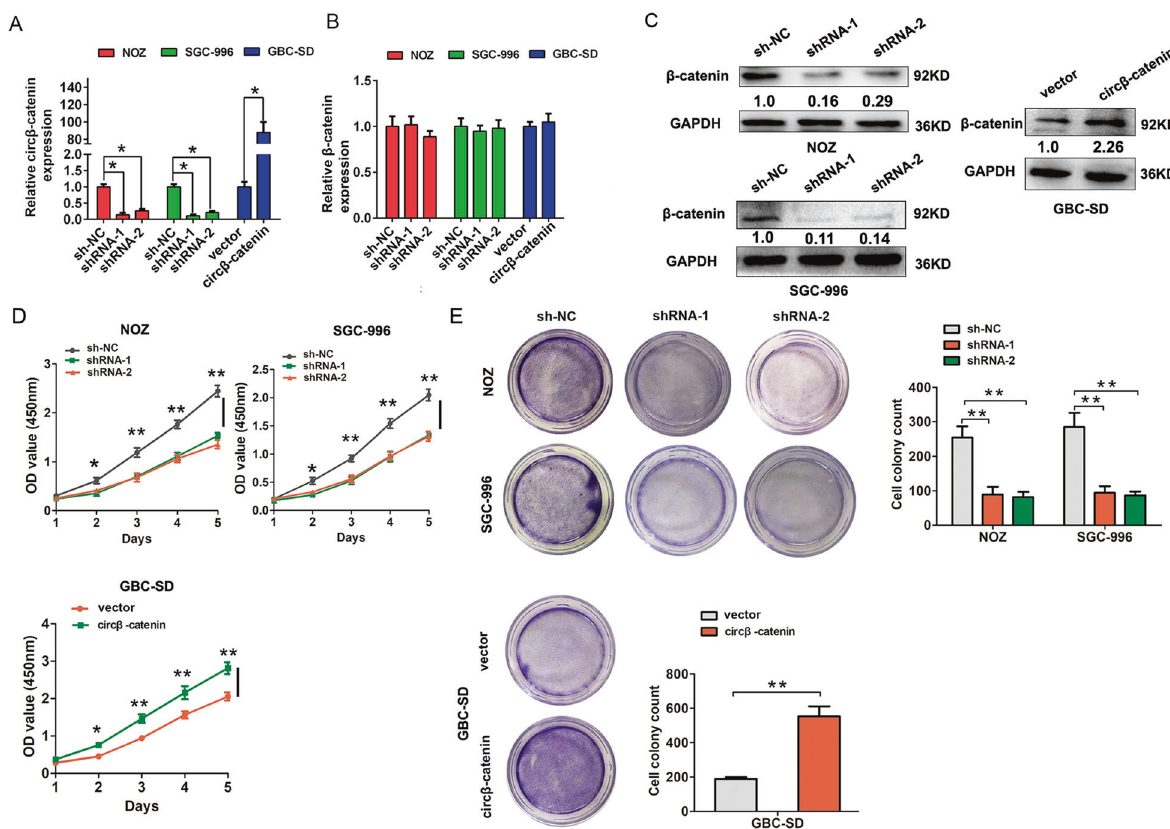
Fig. 2 The circ β -catenin promotes cell proliferation in vitro. A The relative expression of circ β -catenin in NOZ and SGC-996 cells was detected by qRT-PCR analysis after cells were transfected with shRNA-NC, shRNA-1, or shRNA-2 or were transfected with pLCDH-vector or pLCDH-circ β -catenin in GBC-SD cells. B The relative expression of β -catenin in NOZ and SGC-996 cells was detected by qRT-PCR analysis after cells were transfected with shRNA-NC, shRNA-1, or shRNA-2, or were transfected with pLCDH-vector or pLCDH-circ β -catenin in GBC-SD cells. C The relative protein expression of β -catenin in NOZ and SGC-996 cells was detected by western blotting analysis after cells were transfected with shRNA-NC, shRNA-1, or shRNA-2, or were transfected with pLCDH-vector or pLCDH-circ β -catenin in GBC-SD cells. D The cell viability was detected by CCK8 assays in NOZ and SGC-996 cells after cells were transfected with shRNA-NC, shRNA-1, or shRNA-2, or were transfected with pLCDH-vector or pLCDH-circ β -catenin in GBC-SD cells. E The cell colonies number was detected in NOZ and SGC-996 cells after cells were transfected with shRNA-NC, shRNA-1, or shRNA-2, or were transfected with pLCDH-vector or pLCDH-circ β -catenin in GBC-SD cells. Data are shown as mean ± SD. * P < 0.05, ** P <